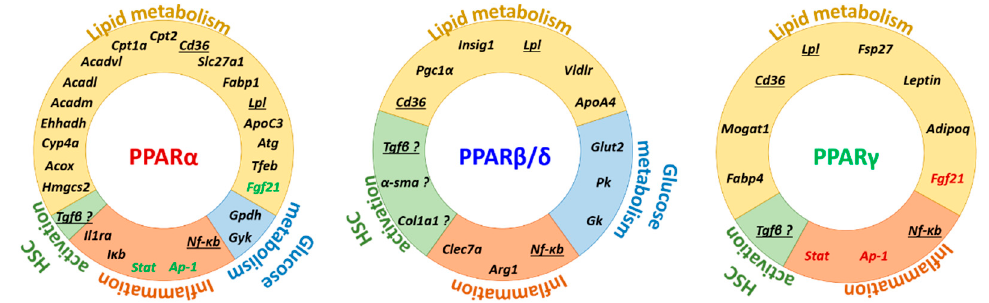
Figure 4. PPAR target genes and their implications in major functions associated with NAFLD pathogenesis. Key target genes of PPAR α ( A ), PPAR β / δ ( B ), and PPAR γ ( C ) and their association with four main biological processes driving NAFLD development and progression, i.e., lipid and glucose metabolism, inflammation, and hepatic stellate cell (HSC) activation. Genes in red, blue, and green are also regulated by PPAR α , PPAR β / δ , and PPAR γ , respectively. Genes whose expression is regulated by all three PPARs are underlined. A question mark (?) after a gene name indicates that PPAR may potentially regulate it. ( A ) PPAR α promotes the expression of genes involved in fatty acid catabolism (Hmgcs2, Acox, Cyp4a, Ehhadh, Acad, Cpt1a, Cpt2, Cd36, Slc27a1, Fabp1) [235,237,321,322], autophagy (Atg, Tfeb) [248,249], and glycerol metabolism (Gyk, Gpdh) [255], and regulates lipoprotein metabolism (Lpl, ApoC3) [220] and hepatic Fgf21 expression [242,243]. It also downregulates inflammatory genes and transcription factors (Nf- κ b, Ap-1, Stat, I κ b, Il1ra) [220,281,300], and may downregulate Tgf β expression [306]. ( B ) PPAR β / δ increases PGC-1 α in muscles [273,275], Insig1 [280] and Cd36 [279] in the liver, and regulates the expression of genes involved in lipoprotein metabolism (ApoA4, Vldlr) [281,284] and glucose utilization [279]. PPAR β / δ regulates the expression of genes induced during alternative macrophage activation (Arg1, Clec7a) [307] and may also influence HSC activation (Tgf β , α -Sma, Col1a1) [309,310]. ( C ) PPAR γ controls the expression of genes involved in adipogenesis (Fabp4, Cd36, Lpl, Mogat1) [296,314] and genes encoding adipokines (Adipoq, leptin, Fgf21) [192,193,289,291]. It also promotes Fsp27 expression in the liver during steatosis [293]. PPAR γ downregulates inflammatory transcription factors (Nf- κ b, Ap-1, Stat) [312,315] and may also reduce expression of Tgf β [318,319]. Abbreviations: Hmgcs2, 3-hydroxy-3-methylglutaryl-CoA synthase 2; Acox, peroxisomal acyl-coenzyme A oxidase 1; Cyp4a, cytochrome P450 family 4 subfamily A; Ehhadh, enoyl-CoA hydratase and 3-hydroxyacyl CoA